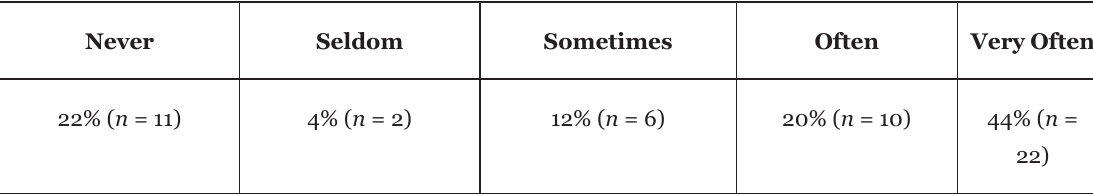
Responses to the Question about the Previous Use of Blackboard CE (formerly WebCT) to Teach